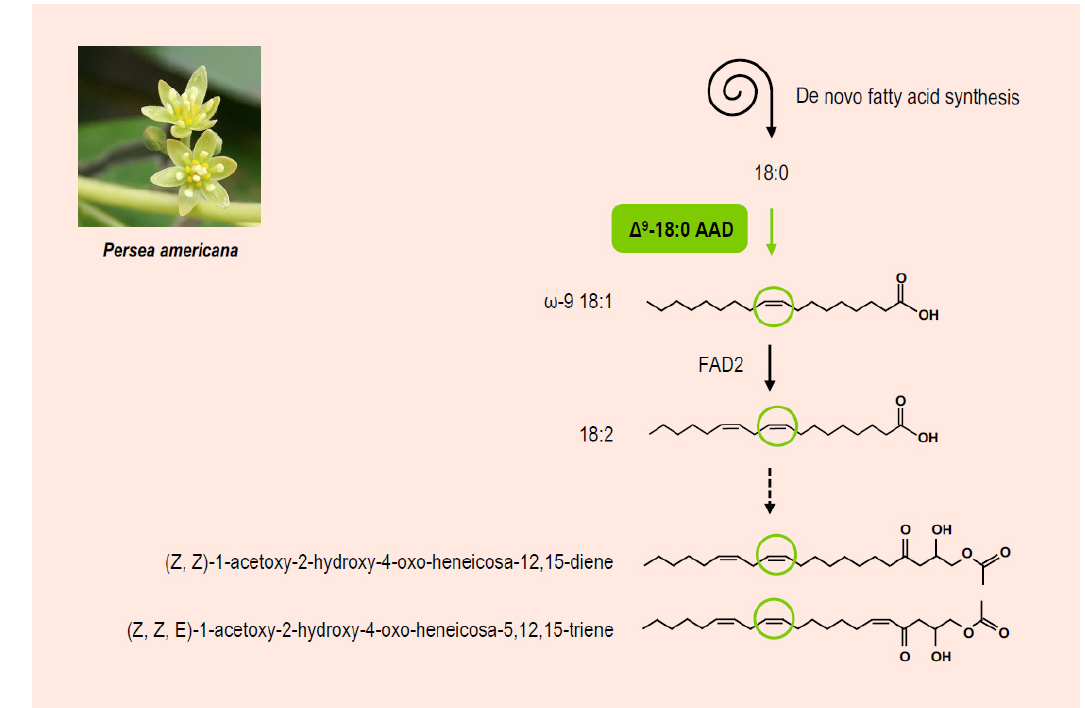
Figure 2. Biosynthesis of antifungal dienes in Persea americana. ∆ 9 -18:0 AAD, ∆ 9 -stearoyl–acyl carrier protein desaturase; FAD2, fatty acid desaturase 2. Picture credit: [66].